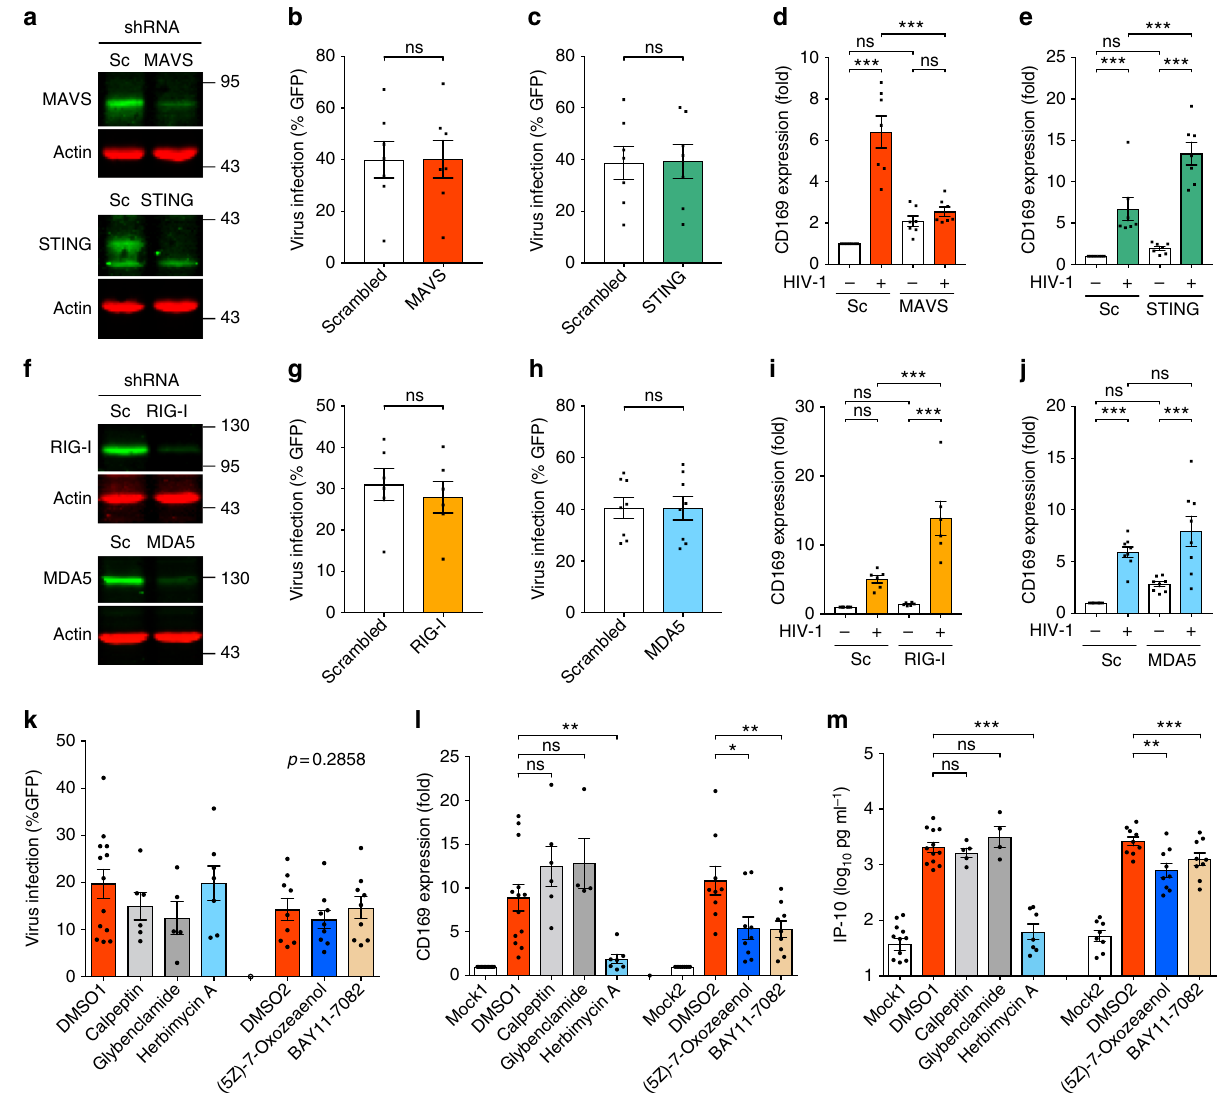
Fig. 5 MDM immune activation is initiated via a MAVS-dependent pathway. a MDMs were transduced with lentivectors expressing shRNA against scrambled sequence (Sc), MAVS or STING, and the expression of host proteins targeted by shRNAs was analyzed by immune blotting. b – e shRNA- transduced MDMs were infected with HIV-1 (Lai Δ envGFP/G) and viral expression (GFP) ( b , c ) and CD169 expression ( d , e ) were analyzed 6 days post infection. f MDMs were transduced with lentivectors expressing shRNA against scrambled sequence (Sc), RIG-I or MDA5, and the expression host proteins targeted by shRNAs analyzed by immune blotting. g – j shRNA-transduced MDMs were infected with Lai Δ envGFP/G and viral expression (GFP) ( g , h ) and CD169 expression ( i , j ) were analyzed 6 days post infection. k – m Effect of inhibitors on HIV-1 infection ( k ), CD169 expression ( l ), and IP-10 production ( m ) in MDMs. MDMs were infected with HIV-1 (MOI of 2) and cultured in the presence of indicated inhibitors for 6 days. mock1/DMSO1: 0.1% DMSO, mock2/DMSO2: 0.01% DMSO. The means± SEM are shown and each symbol represents an independent experiment. Two-tailed p -values: one- way ANOVA followed by the Tukey-Kramer post-test ( d , e , i , j , l , and m ) or paired t -test ( b , c , g , and h ). * p < 0.05, ** p < 0.01, *** p < 0.001, ns: